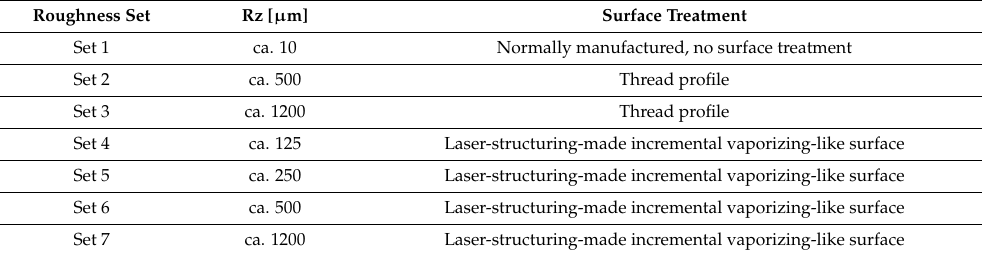
Table 3. Roughness sets.